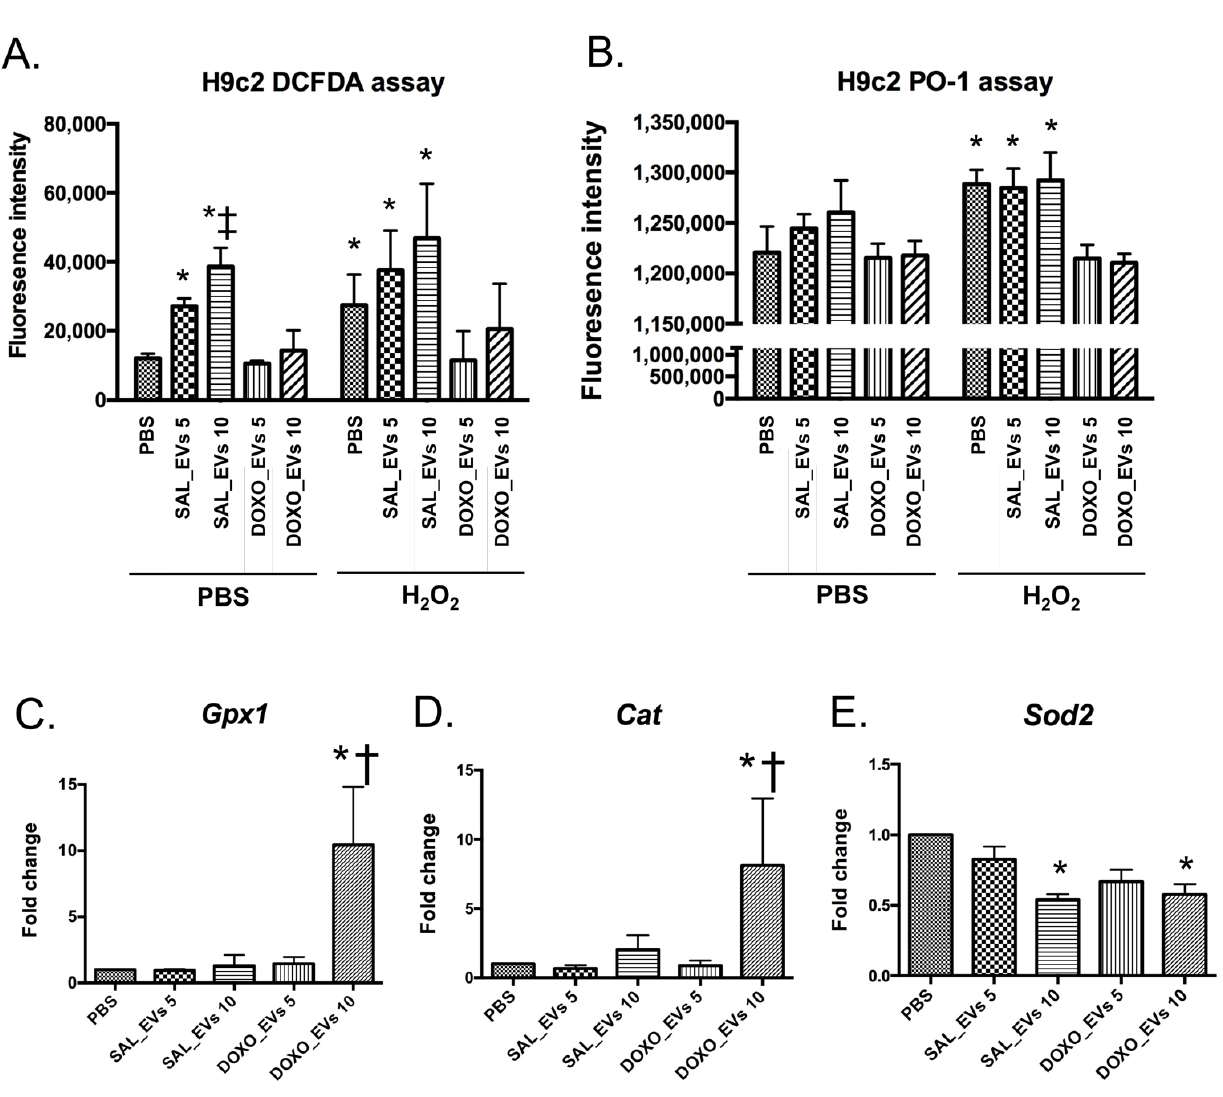
Figure 4. Levels of ROS production measured by DCFDA assay ( A ) and PO-1 assay ( B ) in H9c2 cells pre-incubated with SAL_EVs or DOXO_EVs for 24 h followed by PBS or 100 μ M H 2 O 2 treatment for 10 min; * p < 0.05 vs. no EV, no H 2 O 2 treated control (PBS), ‡ p < 0.05 vs. SAL_EVs 5 Levels of Gpx1 ( C ), Cat ( D ) and Sod2 ( E ) gene expression in H9c2 cells incubated with SAL_EVs or DOXO_EVs for 24 h; SAL_EVs 5 = H9c2 cells pre-incubated with SAL_EVs 5 × 10 9 particles/mL; SAL_EVs 10 = H9c2 cells pre-incubated with SAL_EVs 10 × 10 9 particles/mL; DOXO_EVs 5 = H9c2 cells pre-incubated with DOXO_EVs 5 × 10 9 particles/mL; DOXO_EVs 10 = H9c2 cells pre-incubated with DOXO_EVs 10 × 10 9 particles/mL; * p < 0.05 vs EVs from the same group at concentration 5 × 10 9 particles/mL, † p < 0.05 vs SAL_EVs 10 × 10 9